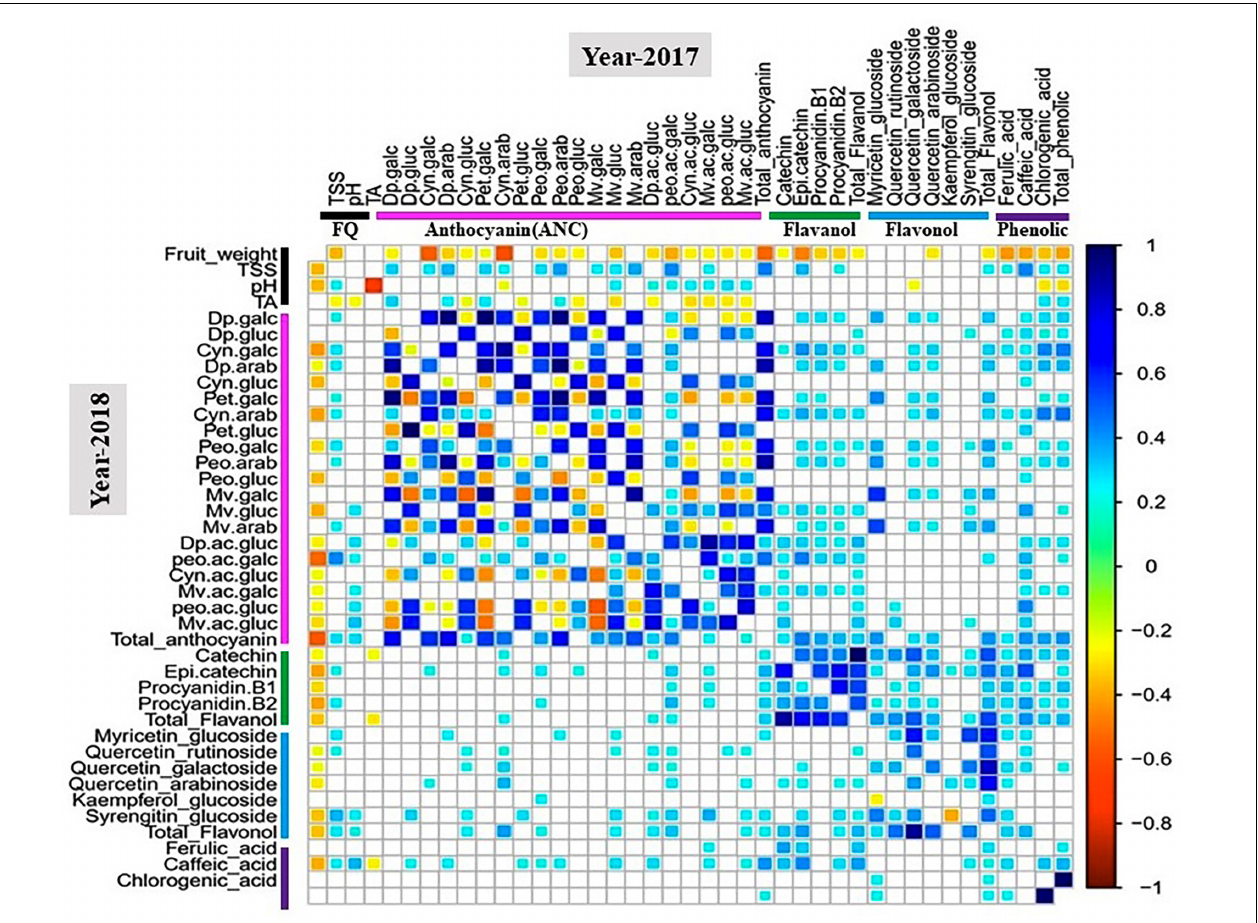
FIGURE 3 | Correlation analysis of metabolite and fruit quality traits for 100 tetraploid accessions. White boxes represent non-significant correlations. The color bar indicates metabolite classes and fruit quality traits. Cyan-to-blue and yellow-to-red colors show significant ( P < 0.05) positive and negative correlation between traits, respectively. Abbreviation: FQ, fruit quality